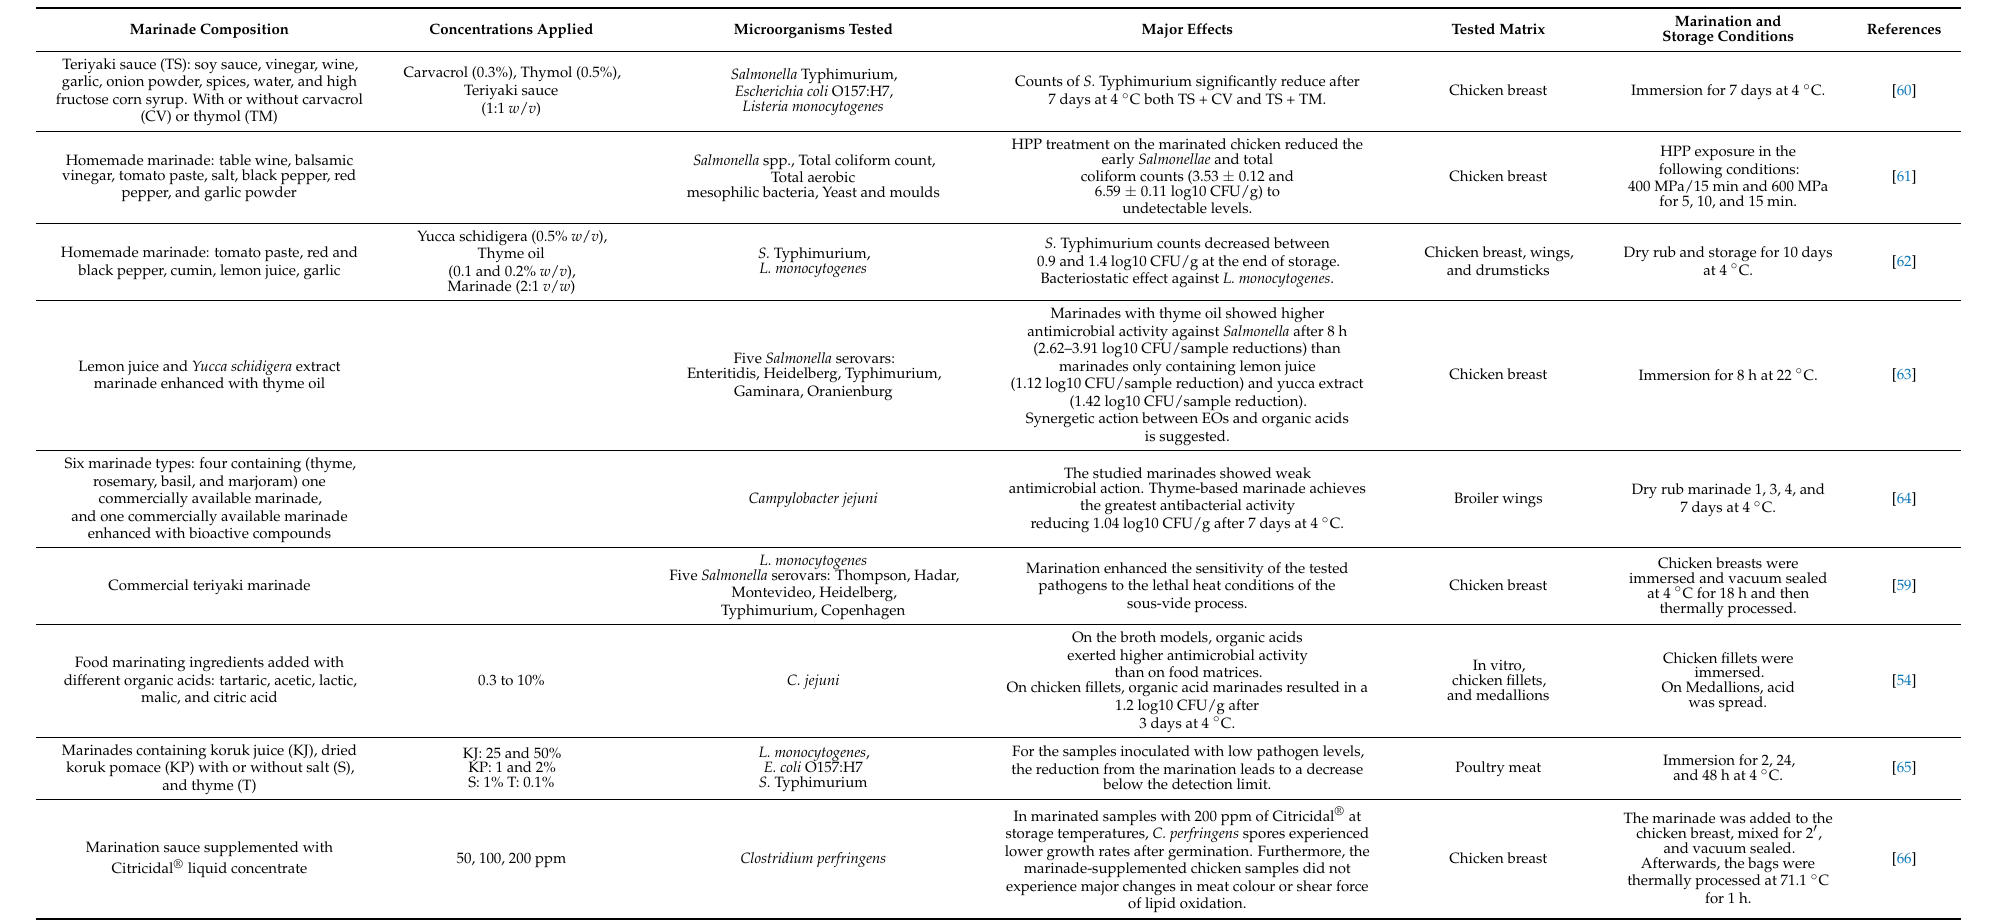
Table 1. Studies evaluating antimicrobial activity of different marinade recipes and